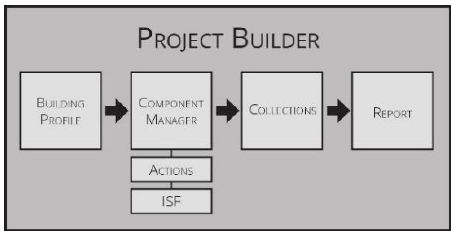
Figure 5. Project Builder sequence